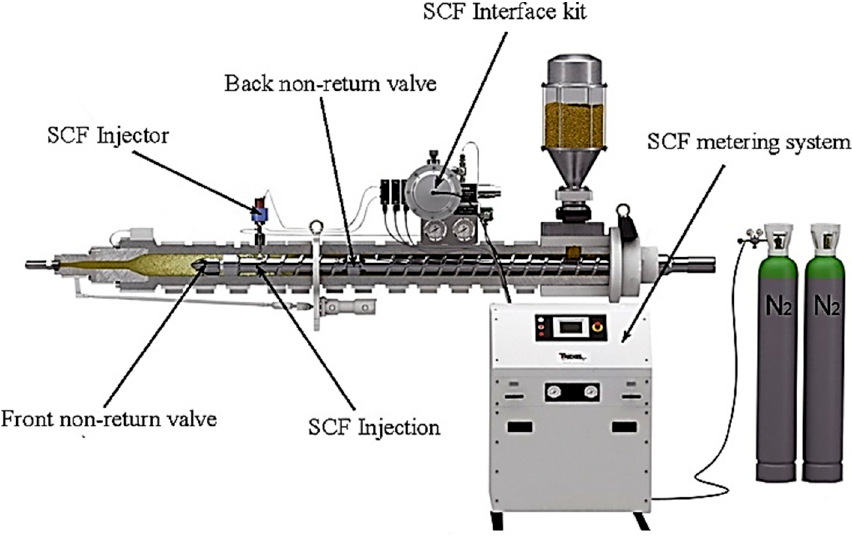
Figure 1. MuCell ® machine system [14].